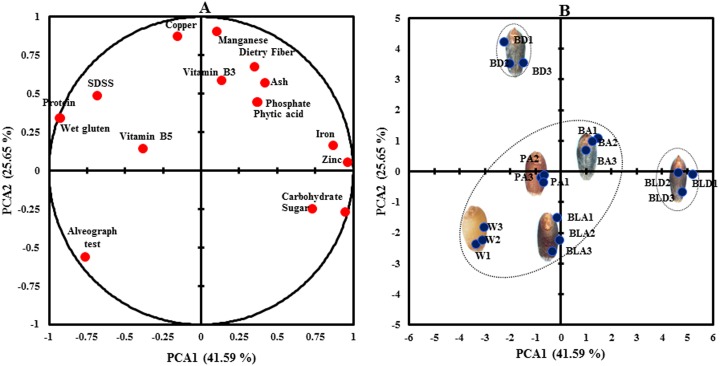
Principal component analysis based on nutritional components.(A) Projection of 17 variables tested on the plane formed by PC1 and PC2 (B) The scatter plot reports the projection of 6 wheat lines. Advanced wheat lines grouped with white wheat line.